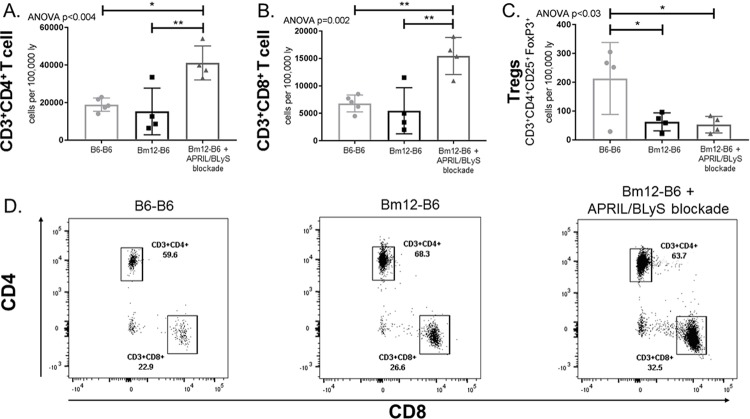
APRIL/BLyS blockade significantly reduces regulatory T cells (Tregs), but increases effector T cell populations.Flow cytometry was used to assess T cell populations in spleen. Each graph shows number of cells per 100,000 lymphocytes. (A) CD3+CD4+ T cells. (B) CD3+CD8+ T cells. (C) Regulatory T cells (Tregs) were defined as CD3+CD4+CD25+FoxP3+. (D) Representative flow cytometry data of CD3+CD4+ and CD3+CD8+ from B6-B6 (Left), Bm12-B6 (Middle), and Bm12-B6 + APRIL/BLyS blockade treated group (Right). Number shown represents percentage of total cells in gate. *p<0.05. **p<0.009.